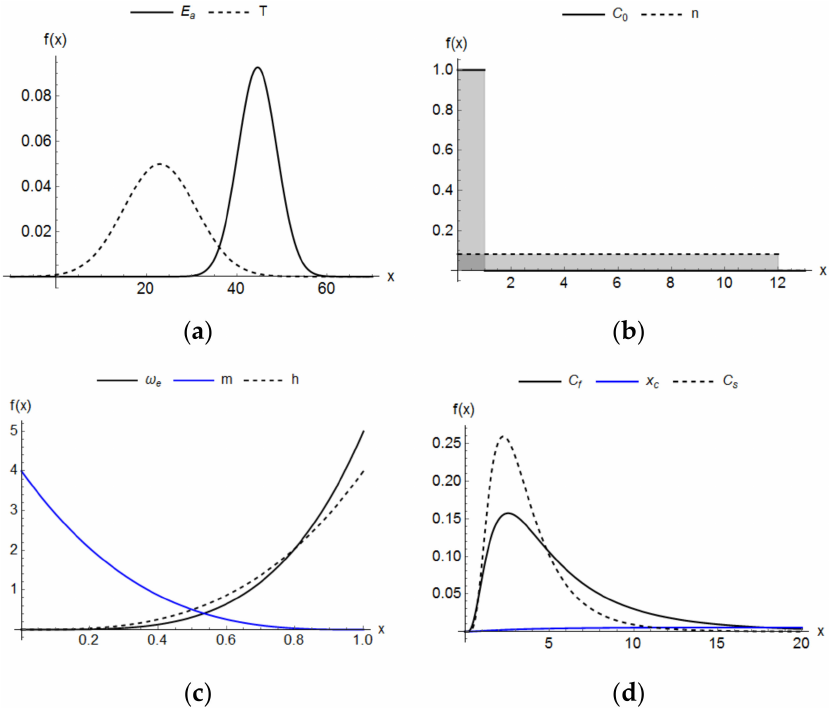
Figure 3. Used probability distributions: ( a ) Normal distribution N( µ , σ 2 ); ( b ) Uniform distribution U(x min , x max ); ( c ) Beta distribution B( α ’, β ’); ( d ) Log-normal distribution logX( µ , σ 2